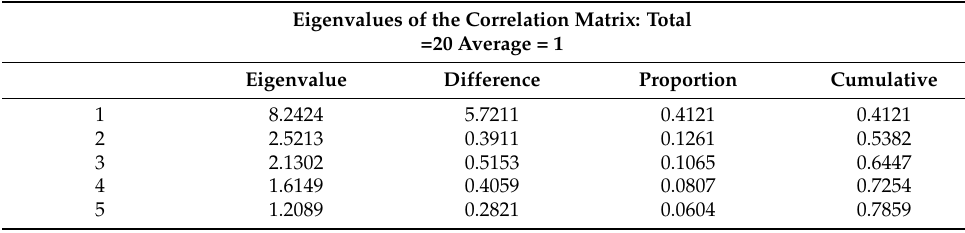
Table 4. Eigenvalues and variance explained by the first five principal components (PCs) of the analysis carried out on the whole dataset of soil indicators (20 variables).